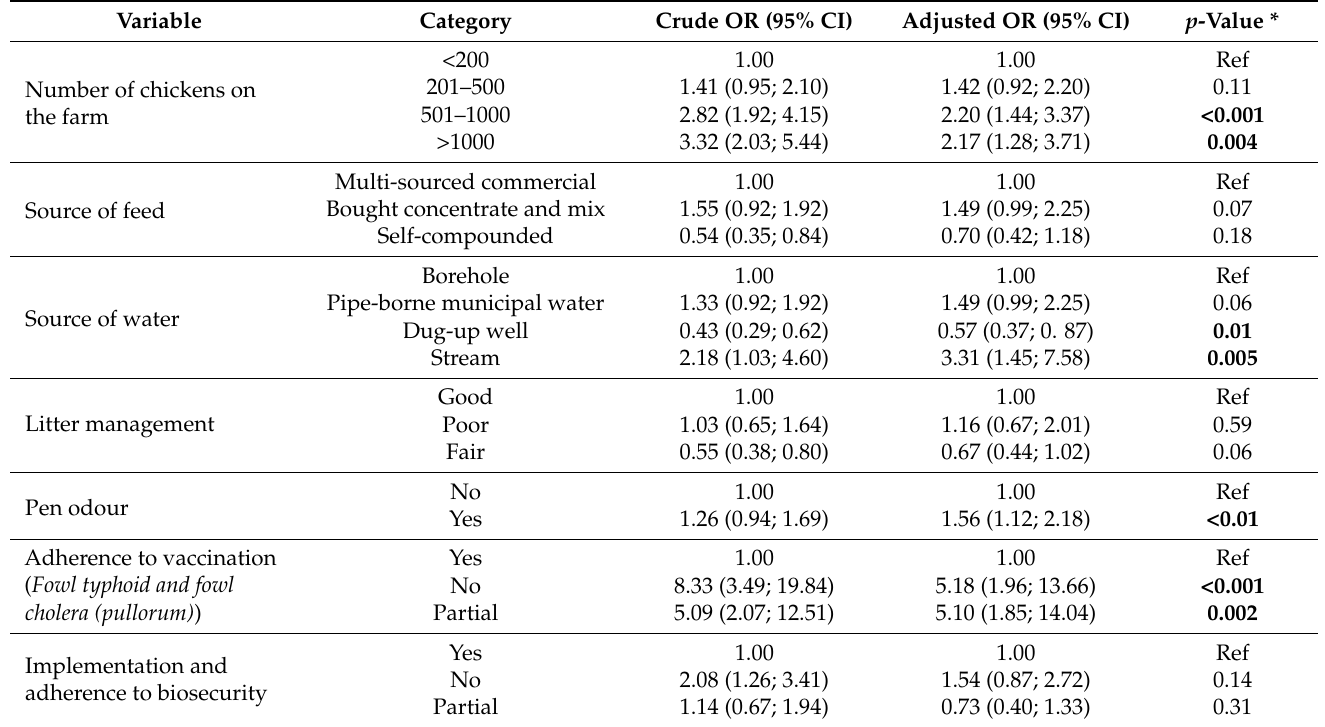
Table 5. Multivariable analysis for contamination of poultry farms with non-typhoidal Salmonella (NTS) in North Central Nigeria.